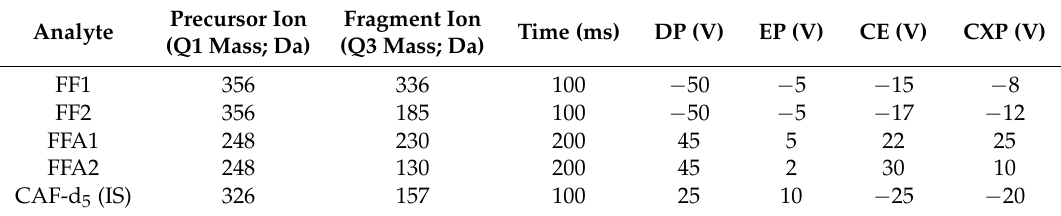
FF1: florfenicol fragment ion 1, used as a quantifier ion; FF2: florfenicol fragment ion 2, used as a qualifier ion; FFA1: florfenicol amine fragment ion 1, used as a quantifier ion; FFA2: florfenicol amine fragment ion 2, used as a qualifier ion; CAF-d 5 : chloramphenicol-d 5 ; IS: internal standard; Q1: quadrupole 1; Q3: quadrupole 3; DP: declustering potential; EP: entrance potential; CE: collision energy; CXP: collision cell exit